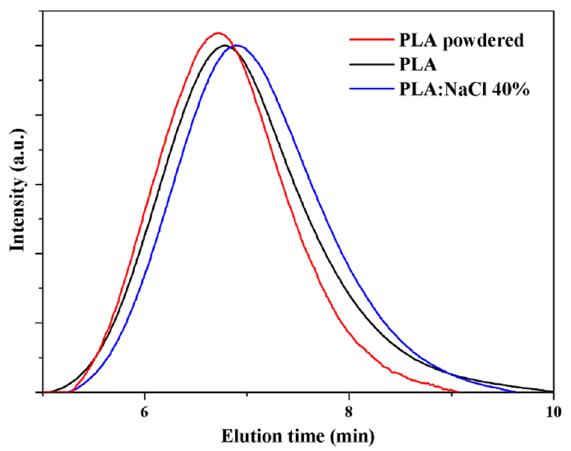
Figure 3. GPC chromatograms of commercial PLA powder, micromolded PLA, and mixtures of PLA:NaCl at 40 wt-% of salt. Processing parameters were 24 µm-300 N-1.2 s for neat PLA and 24 µm-400 N-1.2 s for PLA:NaCl 40%.